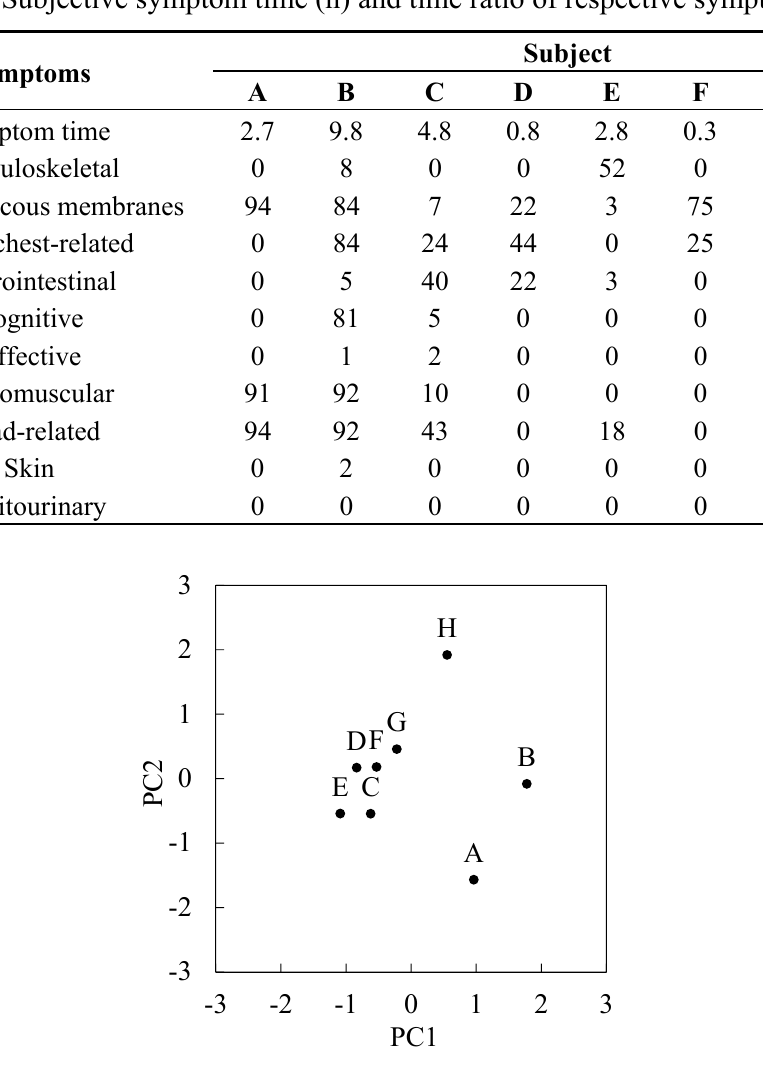
Figure 2. Plot of first principal component (PC1) and second principal component (PC2) scores of eight